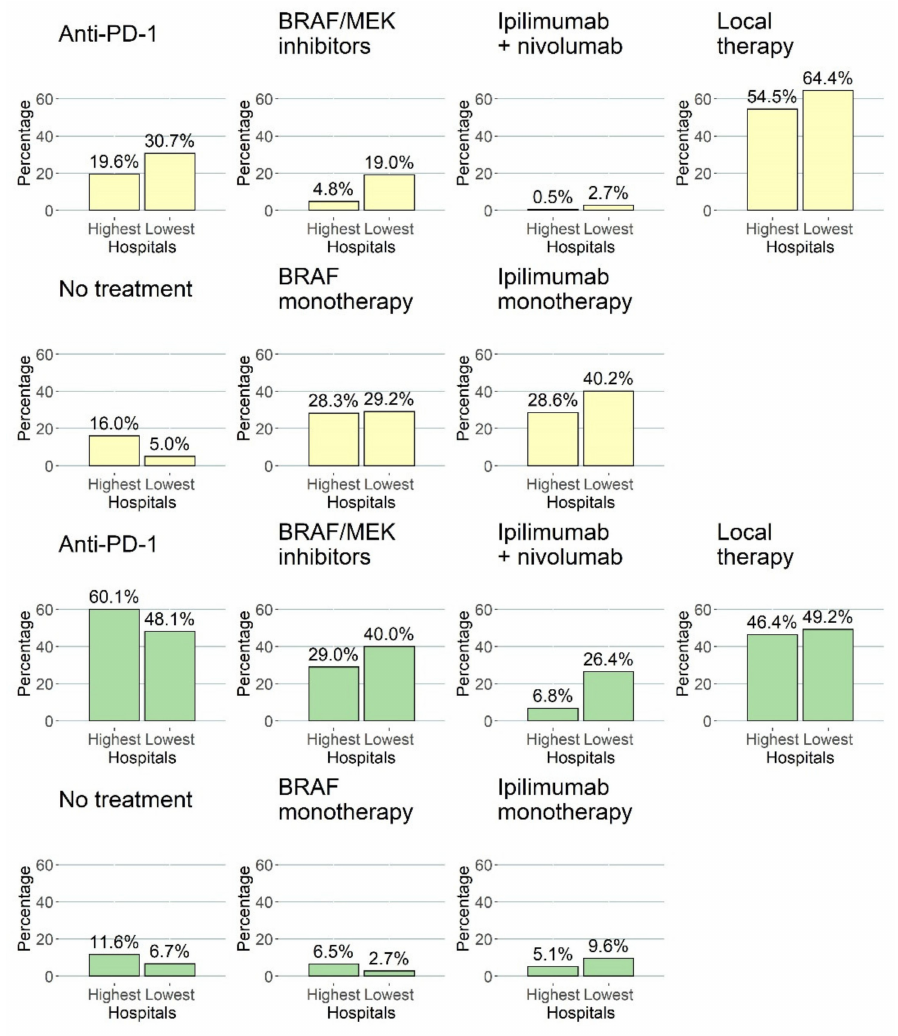
Figure 5. Bar plots showing the percentage of patients with a specific systemic therapy somewhere in their treatment after diagnosis with advanced melanoma. Yellow bars represent patients diag- nosed between 2013–2015, and the green bar plots show patients diagnosed between 2016 and 2017. Columns depicted by “highest” are the three centers with the highest HRs for 2-year survival, and “lowest” are the centers with the lowest HRs for 2-year